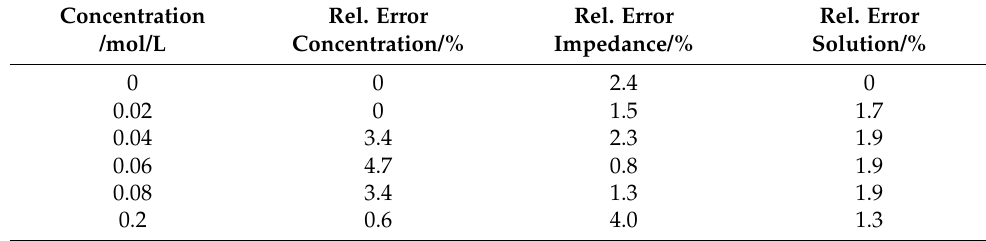
Table 5. Error between titration measurement and sweep measurement of Geo6. Concentration Rel. Error Rel.